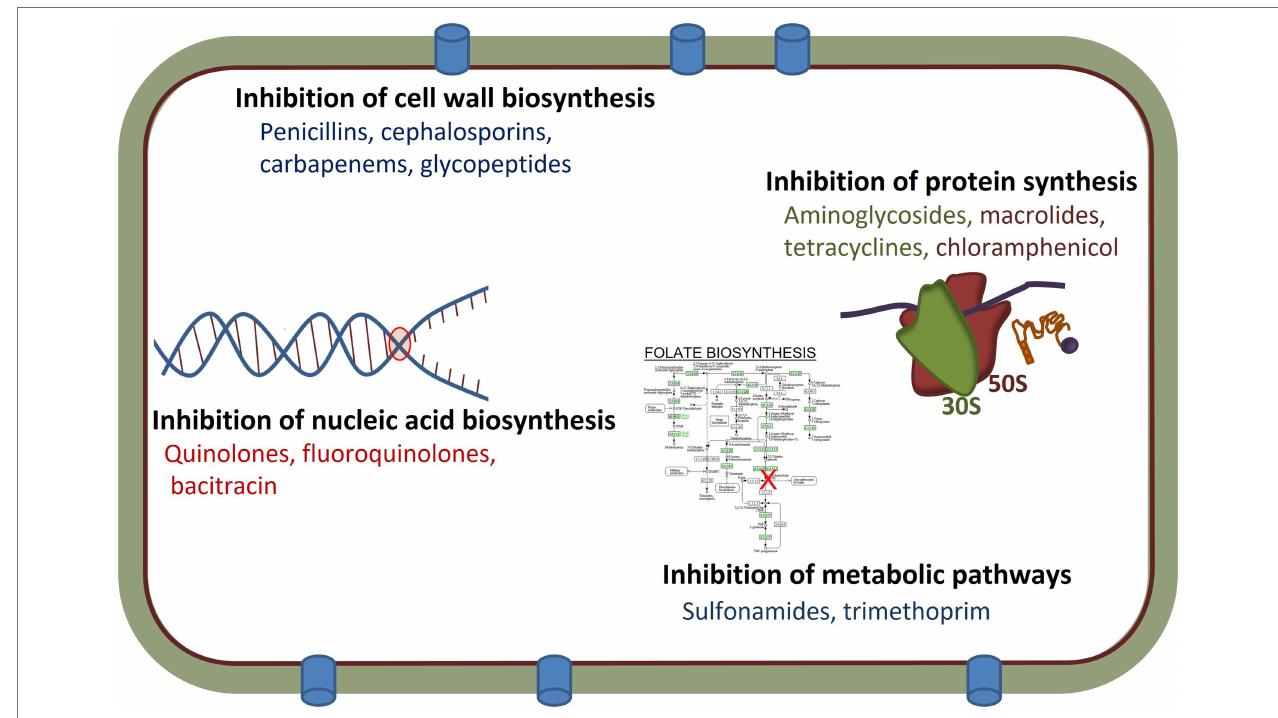
FIGURE 1 | Mechanisms of actions and targets of different antimicrobial agents used in human and/or veterinary